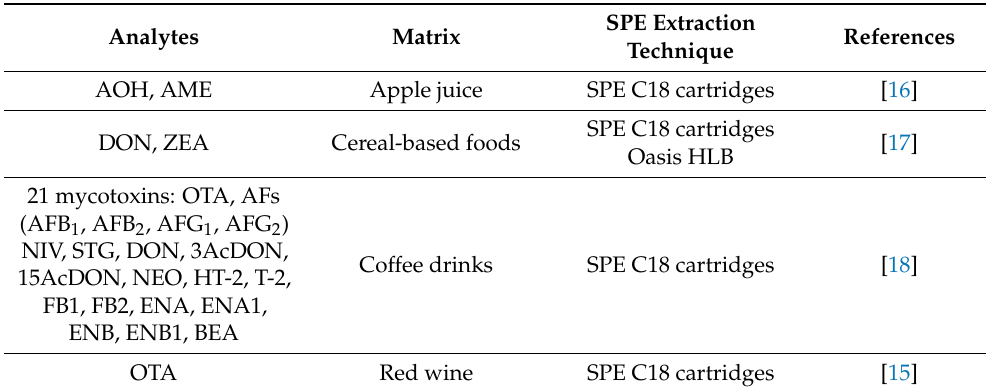
Table 1. SPE methods used in different studies for the extraction of mycotoxins in different liq- uid